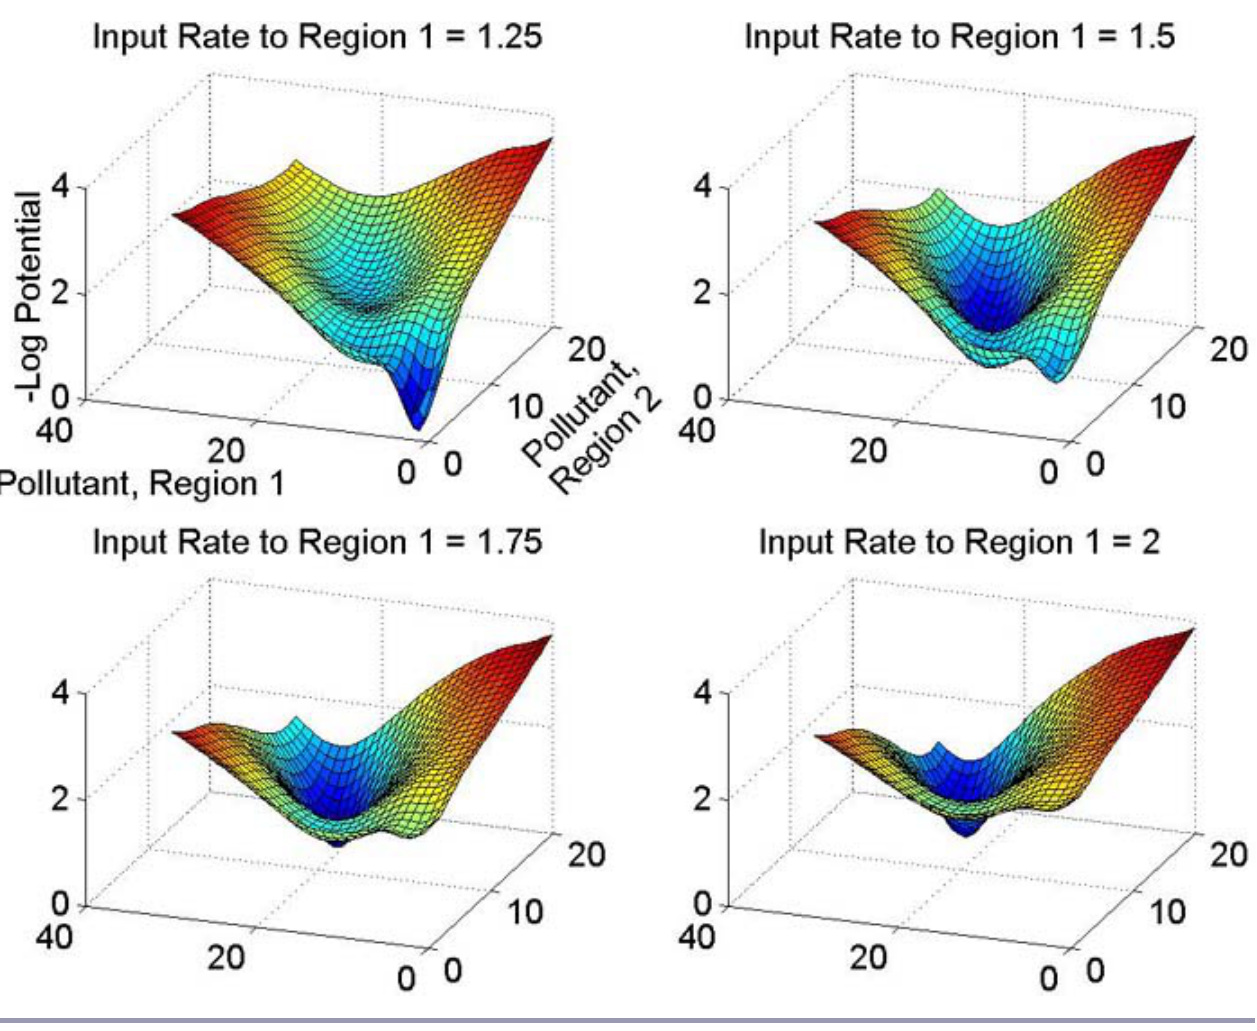
Fig. 4 . Potential surface (negative log potential) vs. pollutant in region 1 and region 2 for four different input rates to region 1. Parameters: M (pollution discharge rate in region 1) = 1.25, 1.5, 1.75, and 2; M 1 2 (pollution discharge rate in region 2) = 0.75; c (decay rate in region 1) = 0.05; c (decay rate in region 1 2 2) = 0.1; D (transport rate between regions) = 0.1; s (maximum sequestration rate) = 0.5; m (the pollutant level at which sequestration is half the maximum rate) = 5; q (which determines the slope of f (P) near P ) = 6. P stands for amount of pollutant, and f(P) scales the sequestration to the amount of